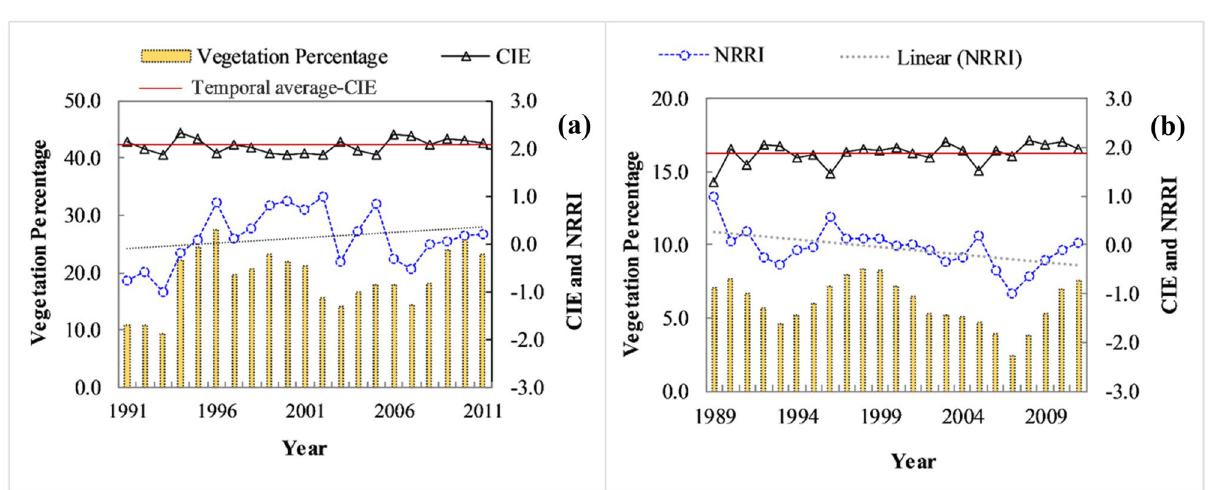
Figure 6. The temporal variation of yearly vegetation percentage, cross-sectional intensity entropy (CIE) and normalised river recovery index (NRRI) in ( a ) the Ong ( b ) the Tel Rivers. The linear trends of NRRI and temporal average-CIE are also